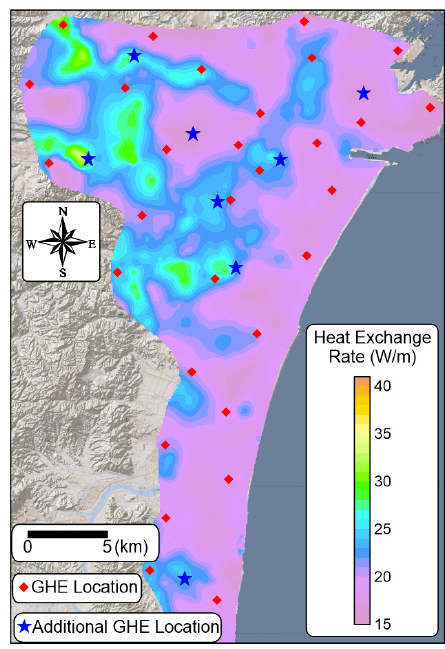
Figure 13. Additional GHE location in the Sendai Plain. Energies 2019 , 12 , x FOR PEER REVIEW